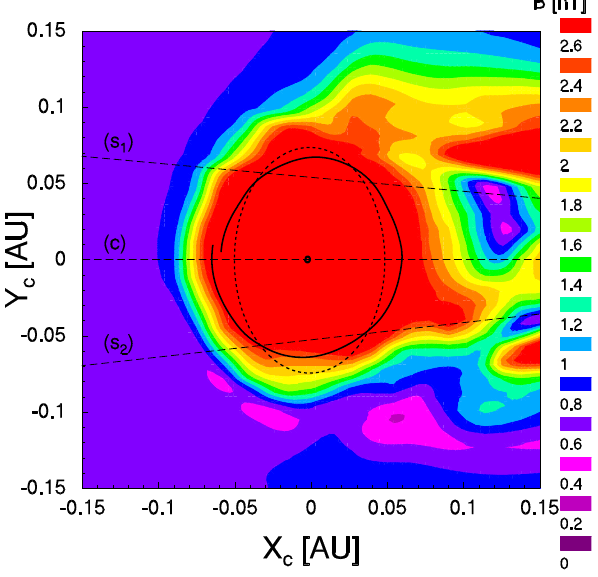
Fig. 6. Cross section through the flux rope around the point C. Outline is similar to Fig.